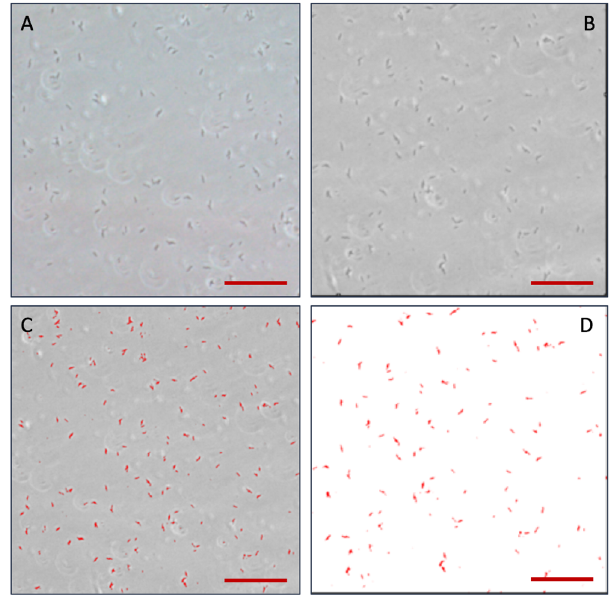
Figure A1. Image processing: ( A ) original image; ( B ) the RGB image was transformed into grey format image; ( C ) image after subtracting background; ( D ) binary image. The scale bar is 40 μ m .